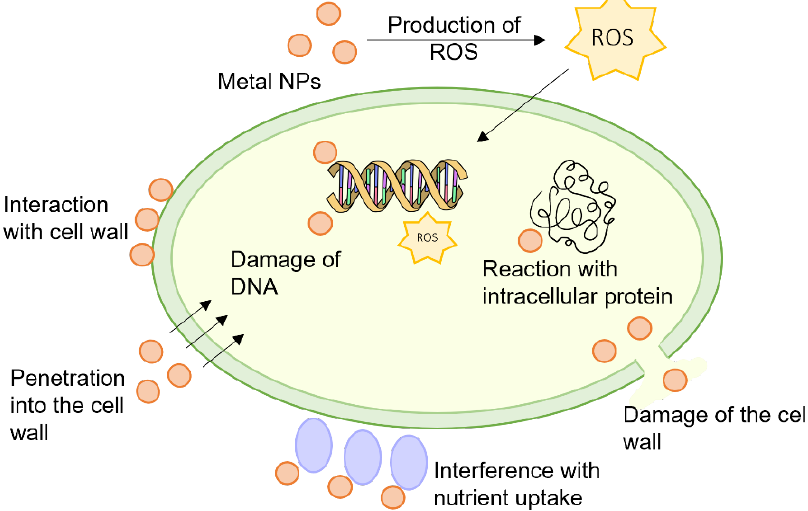
Figure 23. Mechanisms of antibacterial activity of metal nanoparticles. Based on [354] .